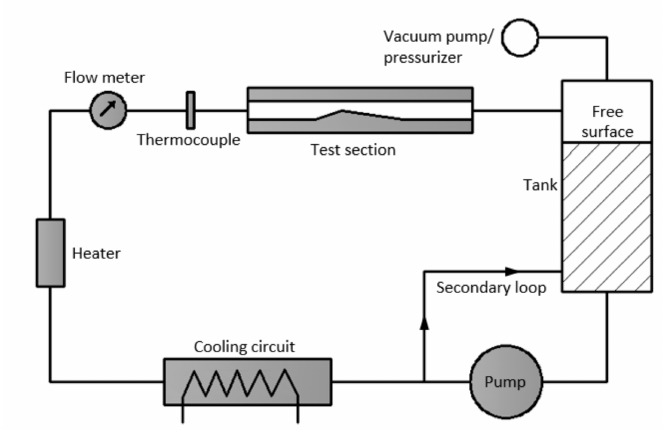
Figure 1. Schematic of the cavitation tunnel.